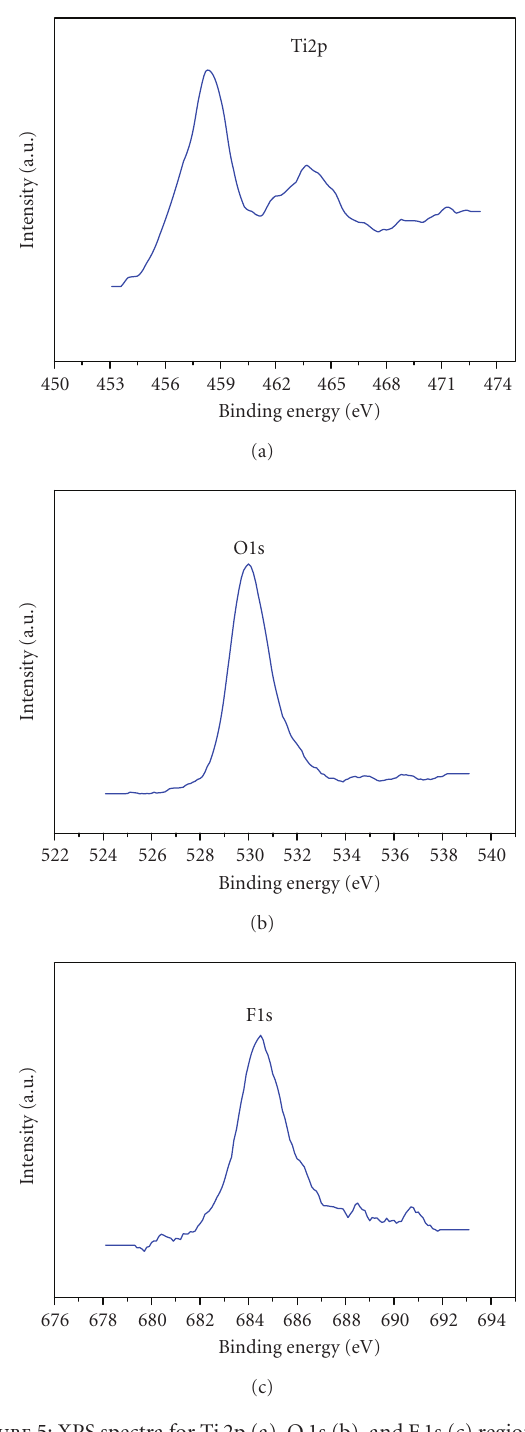
Figure 5: XPS spectra for Ti2p (a), O 1s (b), and F1s (c) regions of TF20 sample calcinated at 400 ◦